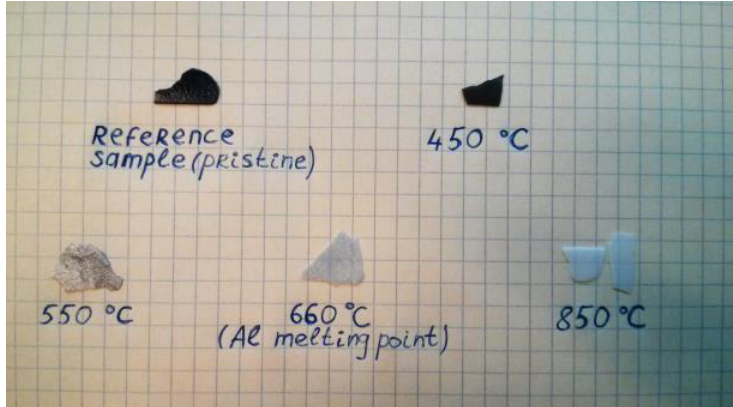
Figure 7. b-PAA samples after thermal treatment at selected elevated temperatures. No correspondence between black color extinction and C-, Al- or S-related impurity oxidation has been confirmed. However, the gradual color transition correlates well with a series of alumina phase transformations extended from 550 to 850 °C.